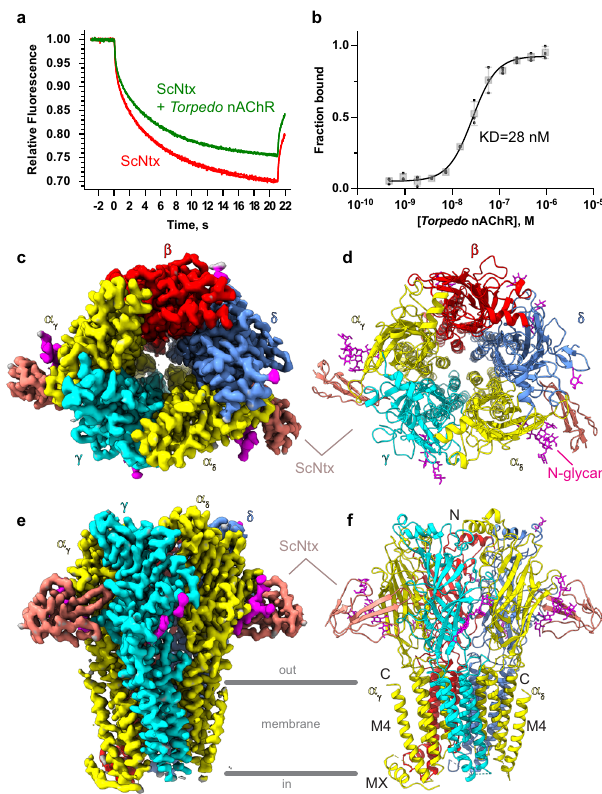
Fig. 1 | Binding of ScNtx to the muscle-type Torpedo nAChR: biophysical and structural characterization. a MST traces of fl uorescently labeled unbound (red) and bound (green) ScNtx to puri fi ed Torpedo muscle-type nAChR reconstituted in asolectin-MSP1E3D1 lipidic nanodiscs. b MST concentration-response curve: change in normalized fl uorescence as a function of Torpedo nAChR concentration. Data are presented as single data points in addition to the mean values±standard deviations. c , e Topandsideviewofthecryo-EMmap. d , f